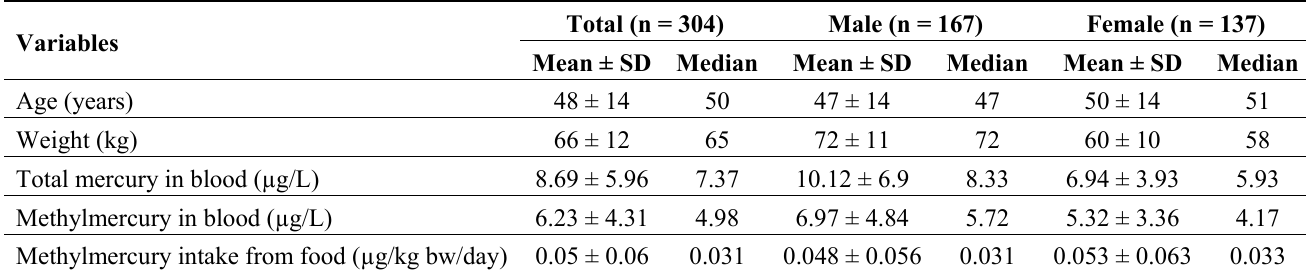
Table 1. Characteristics of the study population.